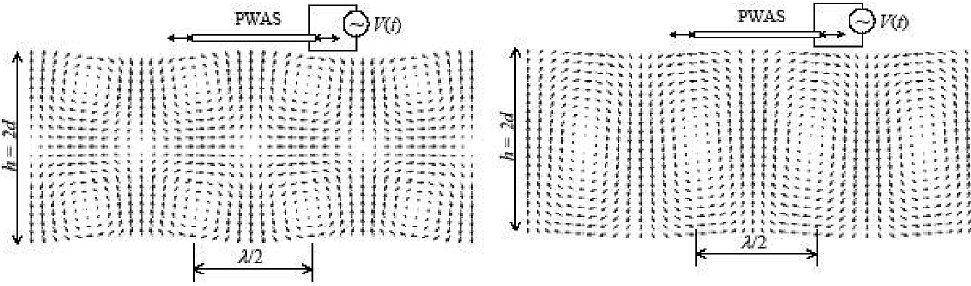
Fig. 2. Symmetric wave (S 0 ) and Anti-Symmetric wave (A 0 )